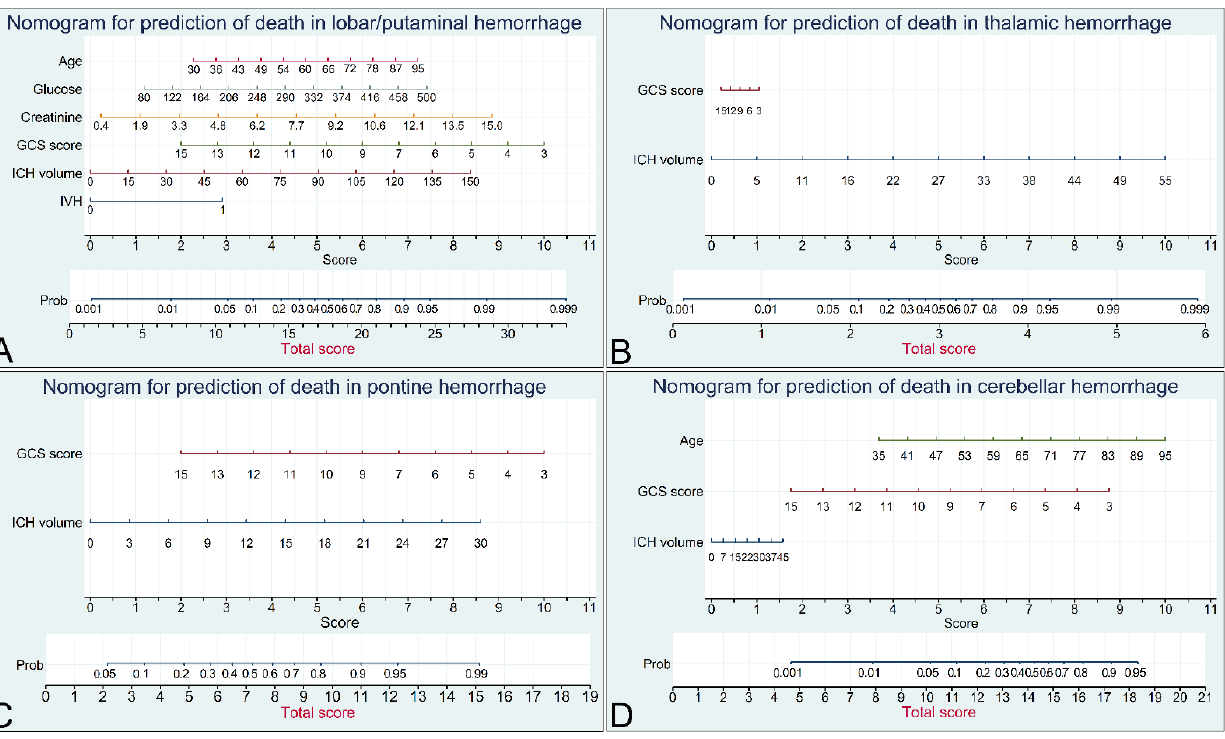
Figure 1. Nomograms for predicting death in patients due to lobar/putaminal ( A ), thalamic ( B ),